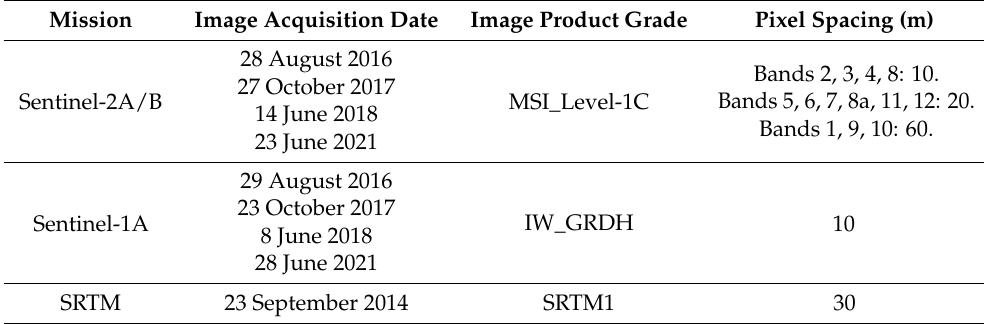
Table 1. Remote sensing images used in this study.